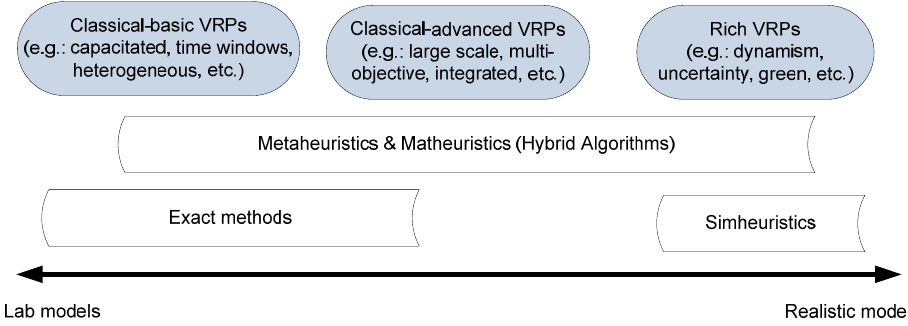
Figure 2. Classification of Vehicle Routing Problem (VRP) models according to their degree of realism.